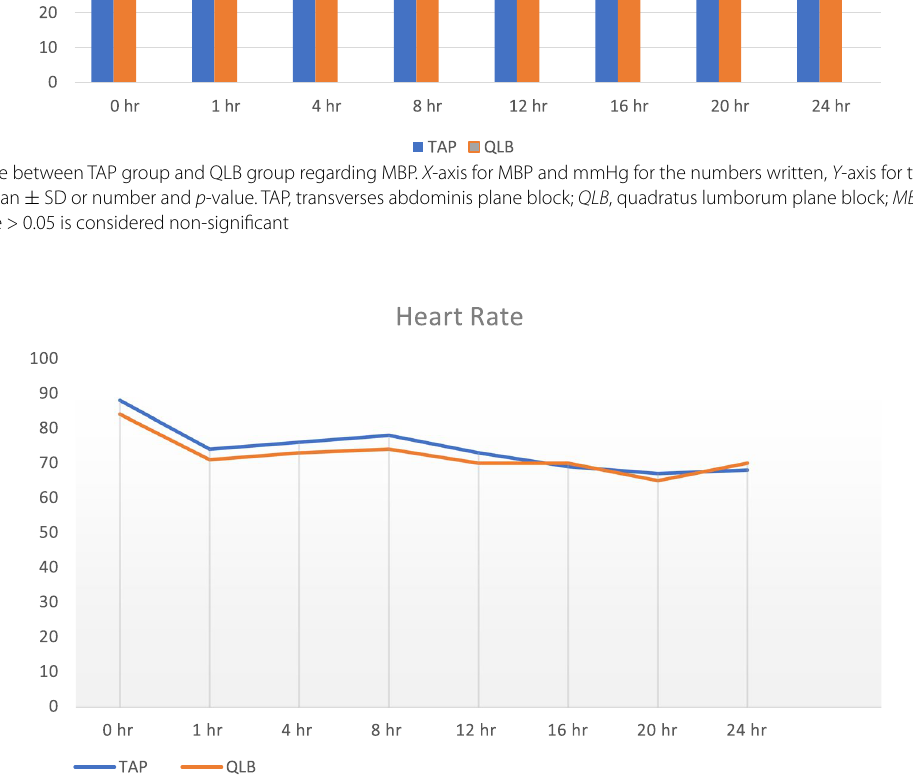
Fig. 3 Difference between TAP group and QLB group regarding HR. X ‑axis for HR and bpm for the numbers written, Y ‑axis for time. Data expressed as mean SD or number and p ‑value. TAP, transverses abdominis plane block; QLB , quadratus lumborum plane block; HR , heart rate, p ‑value > 0.05 ± is considered